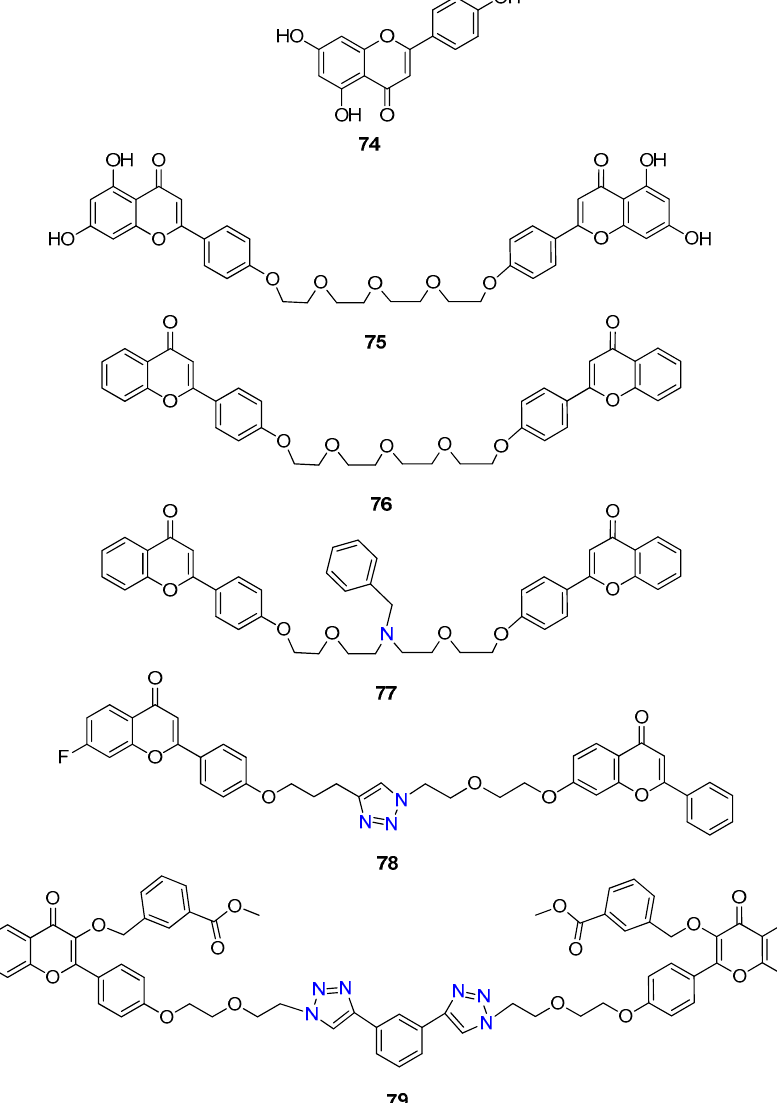
Figure 11. Chemical structures of apigenin ( 74 ) and flavone dimer derivatives 75 – 79.